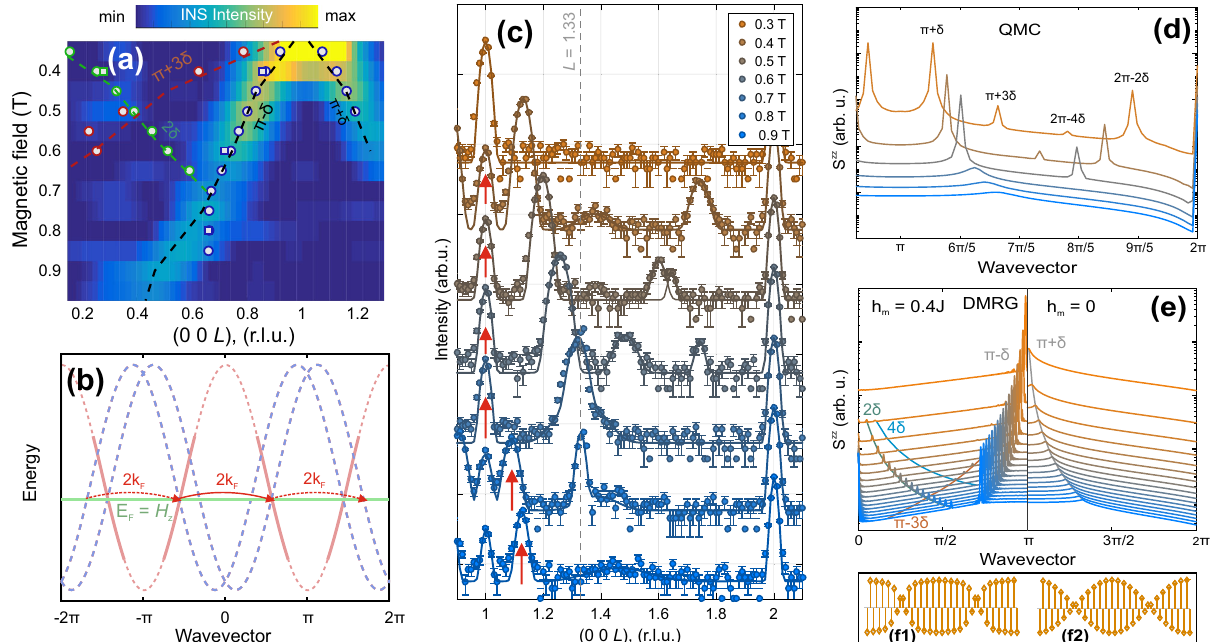
Fig. 3 Magnetic diffraction and origin of the satellites. a Field-dependence of S ( q , ω = 0 + ε ) measured on CNCS at T = 0.05 K. The color map shows the quasielastic signal along the (00 L ) direction. The data are integrated within H = [ − 0.1; 0.1] (r.l.u.); K = [ − 0.15; 0.15] (r.l.u.) and E = [30; 70] μ eV. Blue, green and red dots show positions of Bragg peaks extracted from the FLEXX (circles) and CNCS (squares) measurements; corresponding dotted lines show π + δ ( B ), 2 δ ( B ), and π + 3 δ ( B ) splittings extracted from the soft-mode fi tting. b The red line shows the bare bandstructure in the fermionic representation for a Heisenberg spin chain in a fi nite magnetic fi eld, whereas the blue dotted lines display two folded bands caused by h ic . The green horizontal line shows the position of the chemical potential. Red arrows indicate paths for multiple scattering. Note that the small gap at the Fermi level is not shown. c Representative ENS scans along the (00 L ) direction measured on FLEXX at T = 0.05 K at different magnetic fi elds. Red arrows mark extrinsic re fl ections due to the twin. d S zz ( q , ω = 0) within the spin-density wave (SDW) phase calculated using quantum Monte – Carlo (QMC). e S zz ( q , ω = 0) calculated by density-matrix renormalization group (DMRG) method for different external magnetic fi elds with (left) and without (right) the incommensurate fi eld, h ic . One can see that h ic stabilizes the ordering at the fundamental wavevector 2 k F and produces additional harmonics at 2 nk F . f 1 – f 2 Distorted SDW with square-like modulation calculated by DMRG ( f 1) compared with a harmonic SDW (f2). The distorted SDW in f 1 was calculated using Eq. (3) with h ic = 0.4 J . Note that h ic exceeds the real internal fi eld and was chosen to demonstrate more clearly the nature of the distortions caused by the multiple scattering processes at Q = n q . The intensity axes in c – e are shown on a logarithmic scale and the curves are shifted vertically for ease of viewing. The vertical error bars in c represent statistical errors of one